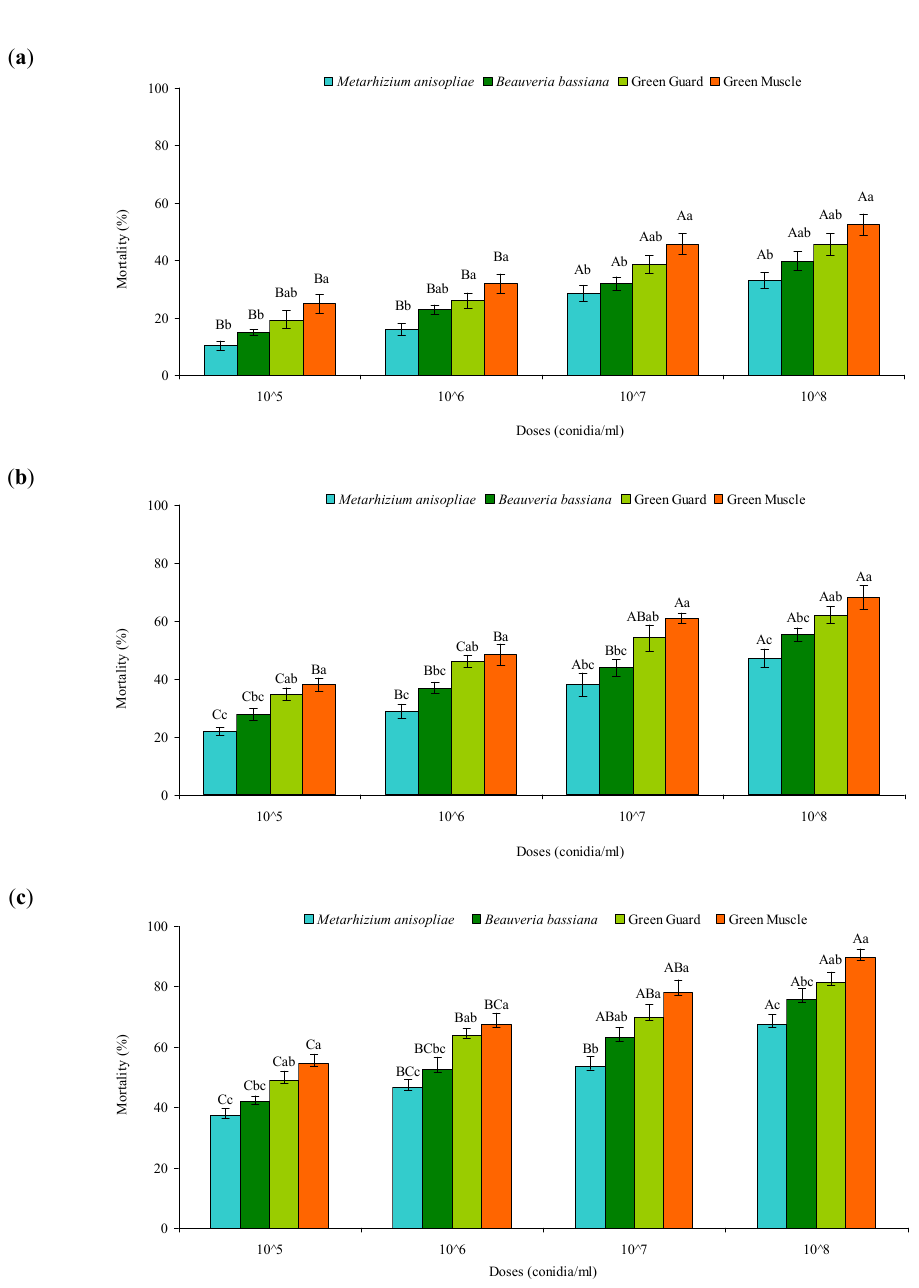
Figure 1. Mean mortality percentages ( ± SE) of 3rd-instar nymphs of S. gregaria after ( a ) 5 days, ( b ) 7 days, and ( c ) 12 days of treatment with various doses (10 5 , 10 6 , 10 7 , and 10 8 conidia/mL) of Green Muscle, Green Guard, B. bassiana , or M. anisopliae . Mortality data were corrected for control mortality, which was <5%. For each subfigure: different lowercase letters indicate significant differences in mortality between each of the EPF; different uppercase letters indicate significant differences in mortality between doses (Tukey’s HSD test at p ≤ 0.05).